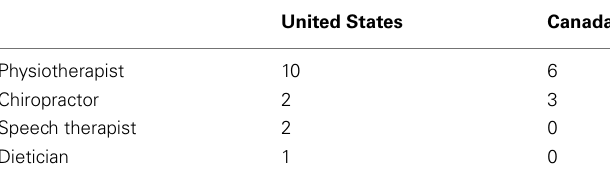
Table 2 | Mean number of visits of the survey respondents to different types of therapists during the 12-months observation